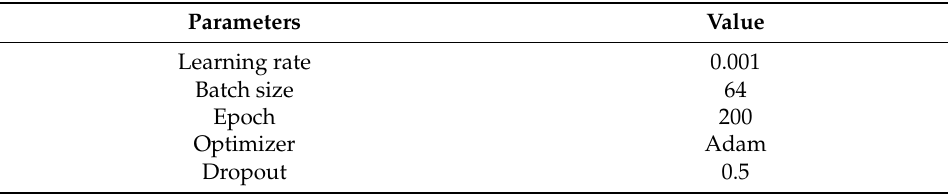
Table 2. Training parameters of the network.